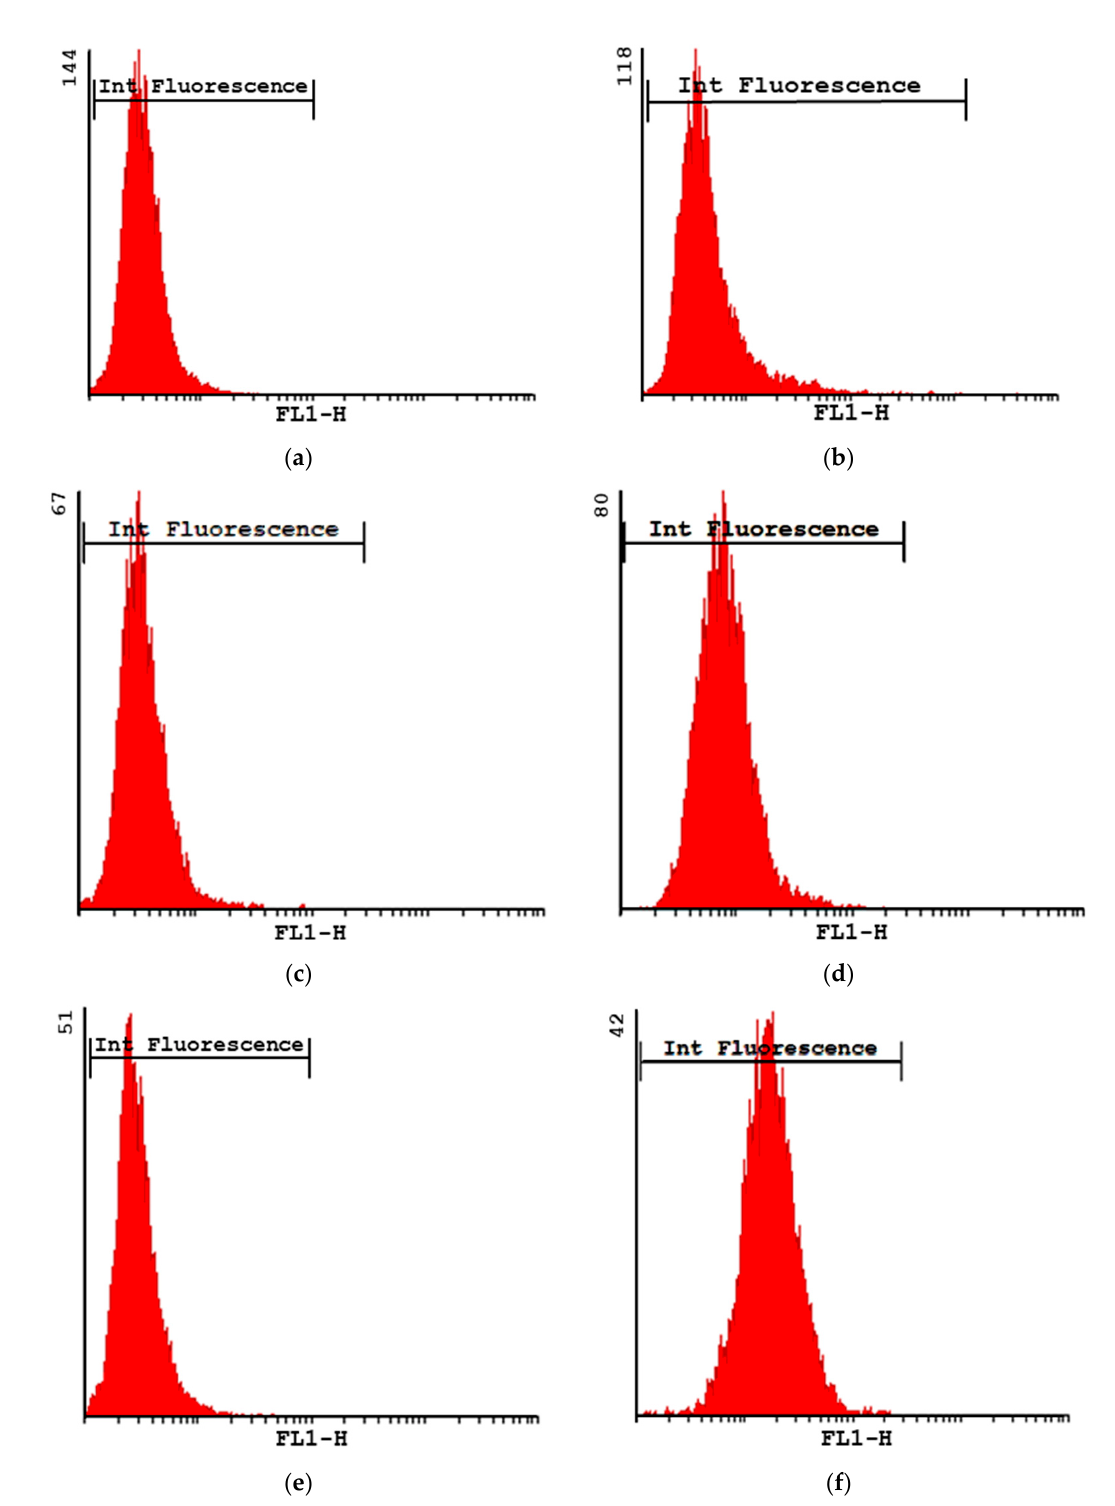
Figure 4. Intensity of fluorescence plots obtained for formulation MP-F at 1 h ( b ), 5 h ( d ) and 24 h ( f ), and their respective controls at 1 h ( a ), 5 h ( c ) and 24 h ( e ). MP-F: FITC-loaded PLGA MPs. FITC: fluorescein-5-isothiocyanate.